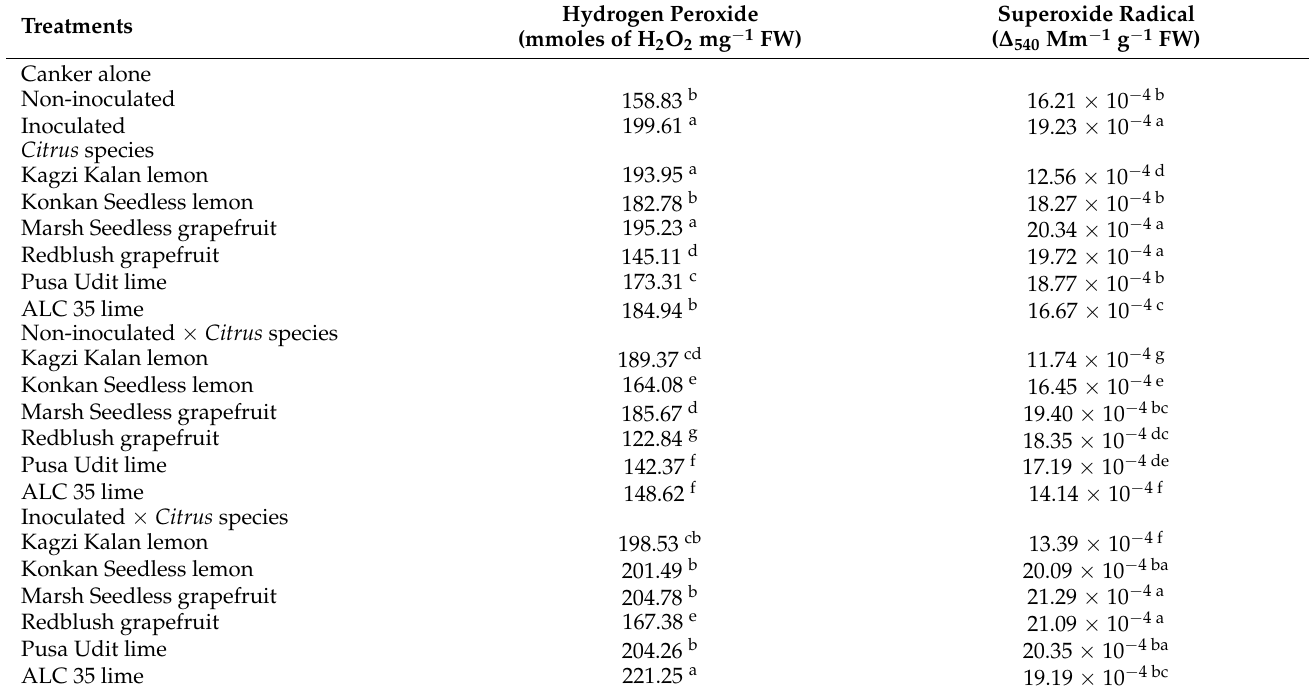
Table 4. Effect of X. citri pv. citri inoculation on reactive oxygen species (H 2 O 2 and superoxide radical) in citrus